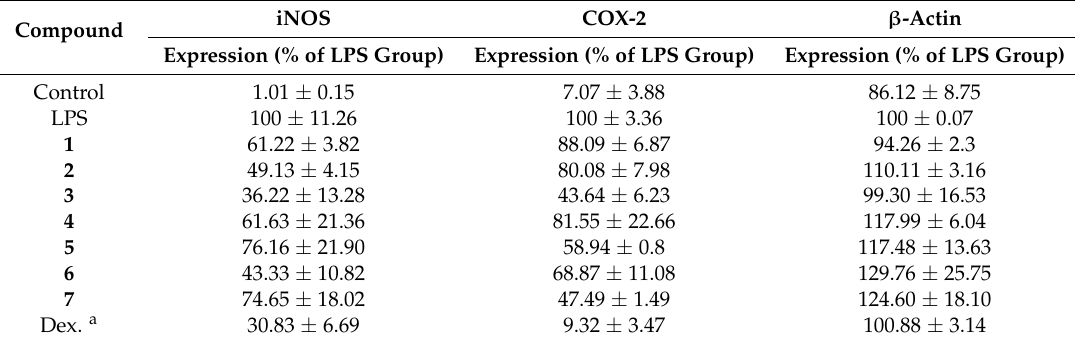
Table 3. Effects of 1 – 7 on iNOS and COX-2 protein expressions in LPS-stimulated macrophages. iNOS COX-2 β -Actin Compound Expression (% of LPS Group) Expression (% of LPS Group) Expression (% of LPS Group) Control 1.01 ±